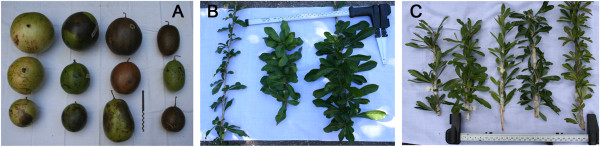
Morphological variation in Crescentia cujete varieties from the study area. A) Fruits (three first columns, from left to right) of sac luch, yaax luch and uas varieties growing in homegardens, and (fourth column) of uas variety growing in putative wild populations, scale: 20 cm; B) Leaves (from left to right) of uas wild variety and two individuals of yaax luch domesticated variety, all three growing in the same homegarden in Pachuitz; C) Leaves of uas wild variety growing in the putative wild population near Chun Ek; ruler in B and C: 50 cm.